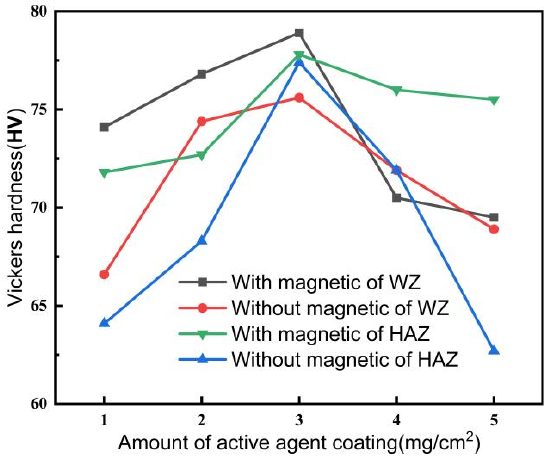
Figure 8. Hardness curve of welded joint and the heat ‐ affected zone under different amounts of coating with and without the magnetic field.